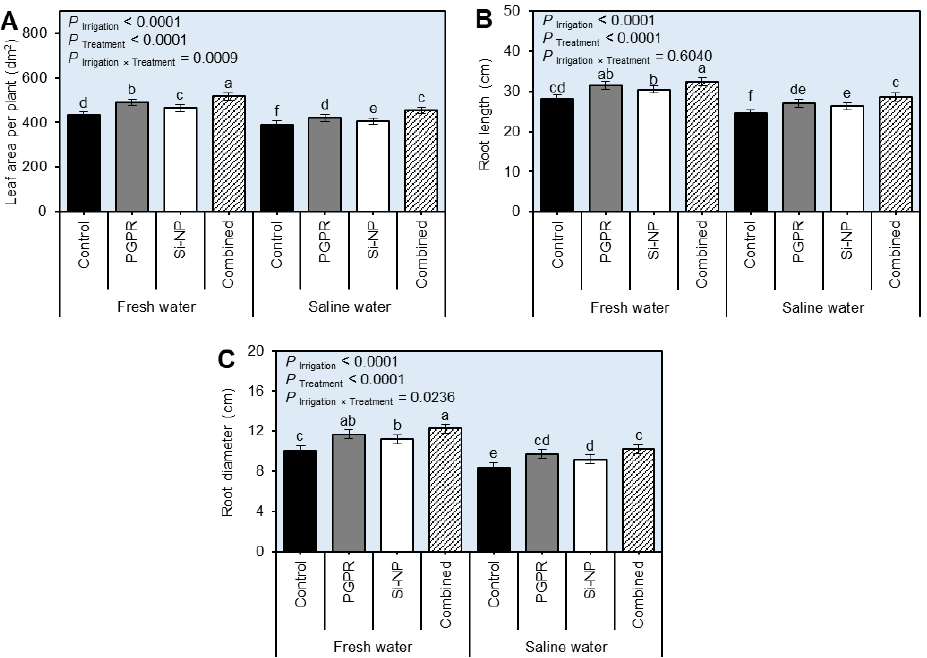
Figure 1. Effect of seed inoculation with PGPR and/or Si-NP foliar application on the growth of sugar beet plants grown in salt-affected soil and subjected to saline water irrigation during the 2019/2020 season. ( A ) Leaf area per plant (dm 2 ), ( B ) root length (cm), and ( C ) root diameter (cm) during the 2019/2020 season, respectively. Data presented are the means ± standard deviation (mean ± SD) of three biological replicates. Different letters signify statistically significant differences between treatments according to Tukey’s HSD test ( P Irrigation × Treatment ≤